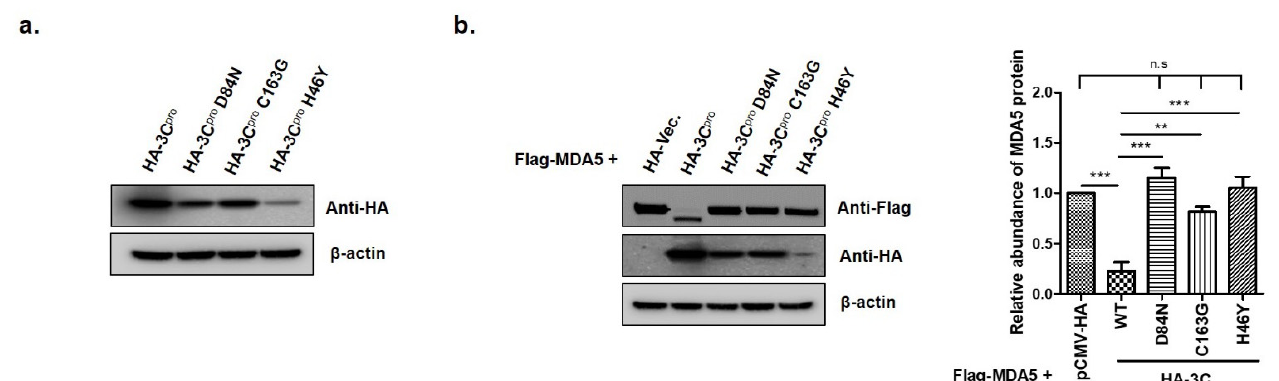
Figure 5. The effects of catalytic residues H46, D84 and C163 of the 3C pro active site on FMDV 3C pro -induced MDA5 protein reduction. ( a ) HEK293T cells (1.5 × 10 6 cells) were transfected with HA-tagged empty vector, 3C pro or individual mutants of 3C pro (2 µ g) for 12 h. ( b ) HEK293T cells (1.5 × 10 6 cells) were co-transfected with HA-tagged, MDA5-expressing plasmid (2 µ g) and various plasmids expressing 3C pro or individual mutants of 3C pro (2 µ g) for 12 h. The abundance of MDA5 proteins was calculated by Image J software to quantify the band intensity, normalized to β -actin and respectively compared with the group of HA-Vec. or HA-3C pro . The result from one of the triplicate experiments are shown and presented as mean ± SEM (**, p < 0.01; ***, p < 0.001 and n.s., not significant).